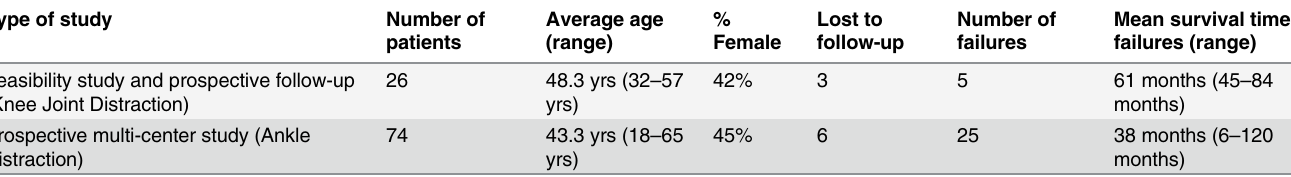
Table 1. Overview of studies used to derive data for KJD regarding time to